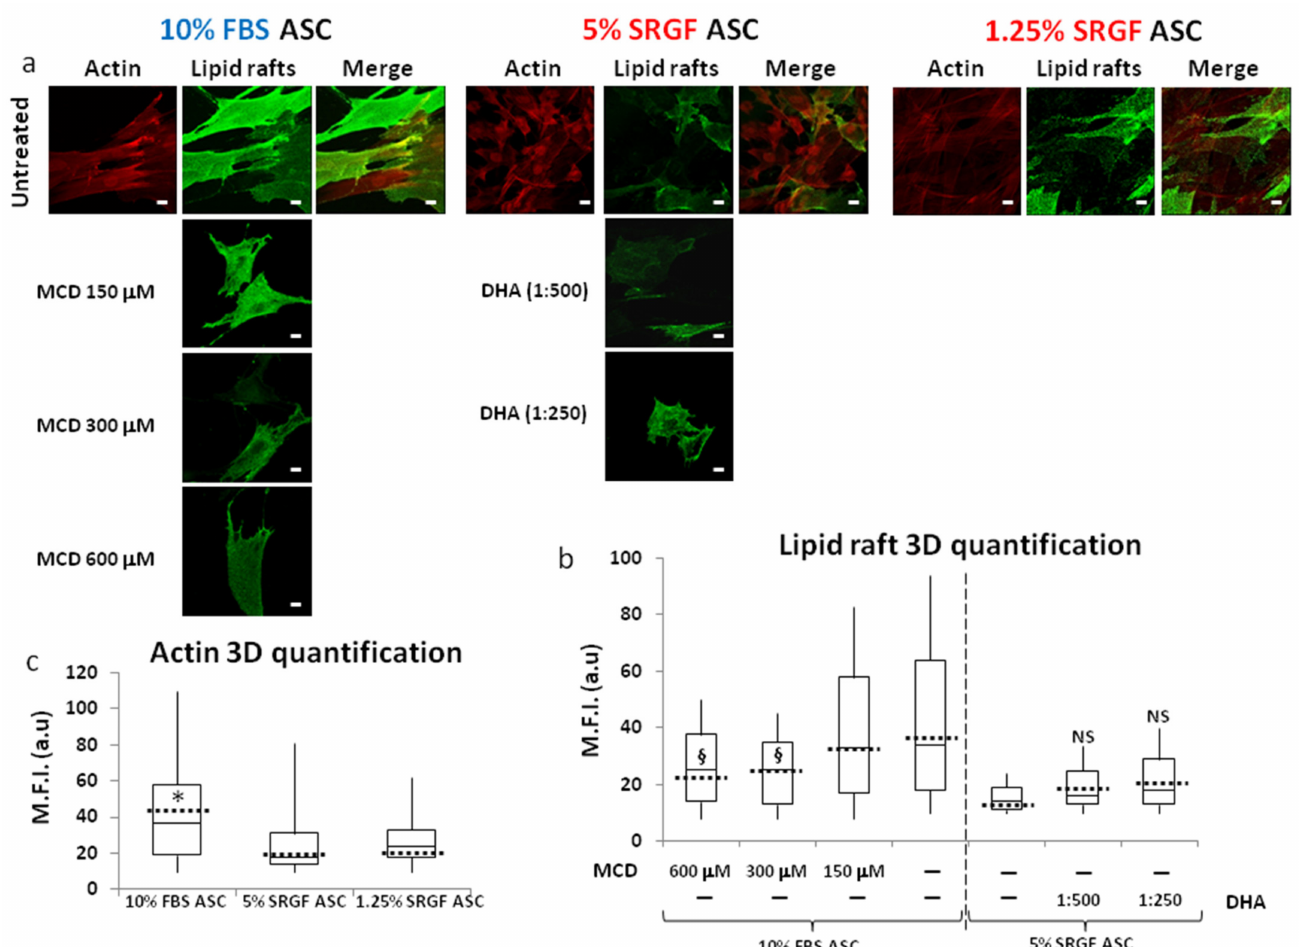
Figure 7. ( a ) reports representative images of 10% FBS and 5% and 1.25% SRGF ASC labelled to detect both total intracellular actin as well as lipid rafts. Moreover, ( a ) reports also images of lipid raft staining performed in 10% FBS ASC treated with non-toxic concentrations (150 µ M, 300 µ M, and 600 µ M) Methyl- β -cyclodextrin (MCD). In parallel, images of lipid raft labelling performed in 5% SRGF ASC supplemented with higher (1:250) or lower (1:500) concentrations of doxosahexaenoic acid (DHA) were reported. Scale bars: 5 µ m. Quantification of lipid raft related mean fluorescence intensity in each image of